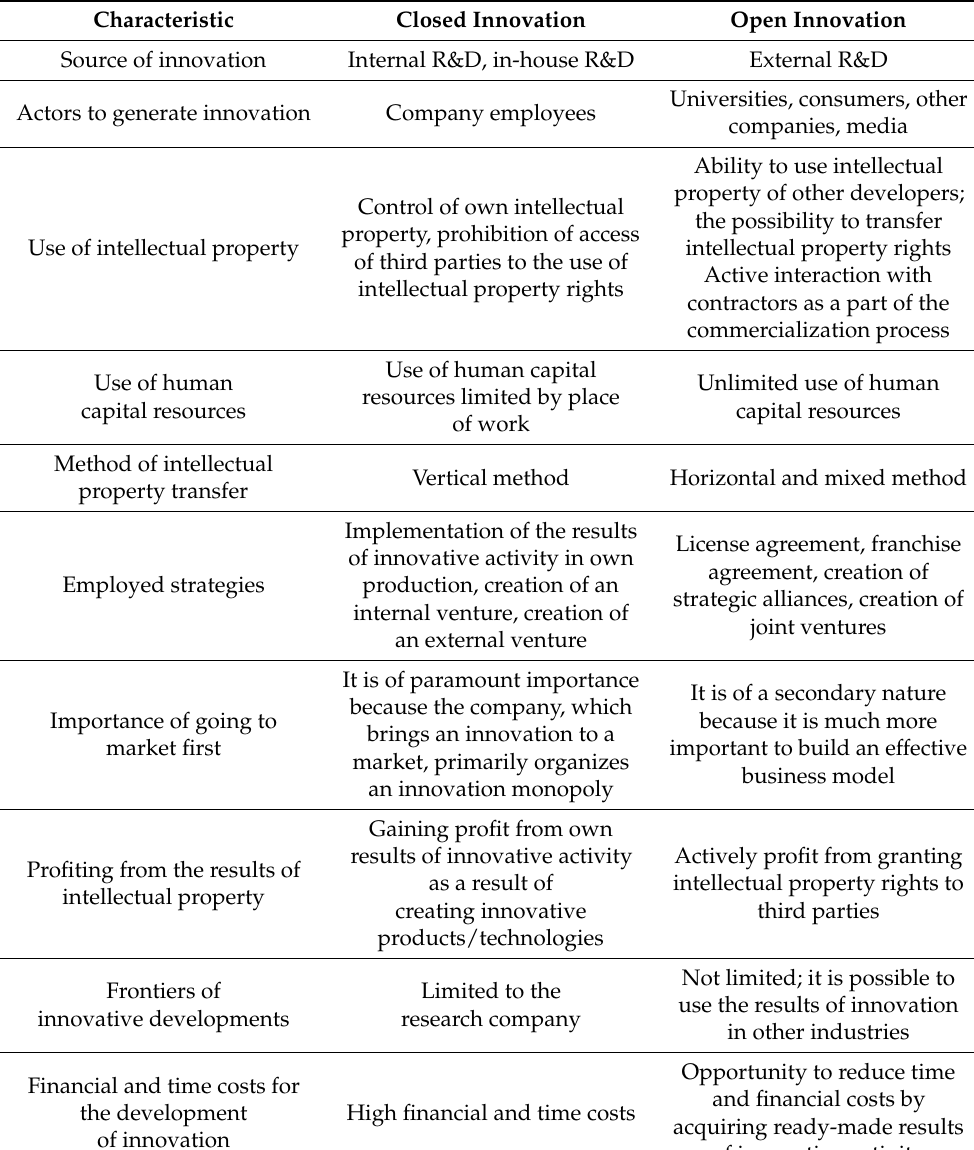
Table 1. The comparison between the concepts of “closed” and “open” innovation in terms of major